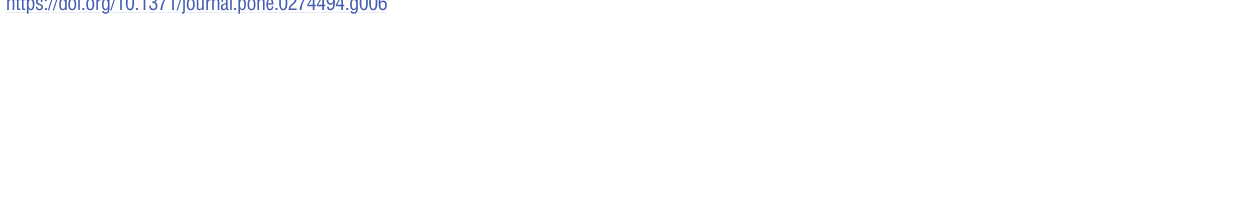
PLOS ONE | https://doi.org/10.1371/journal.pone.0274494 September 9,